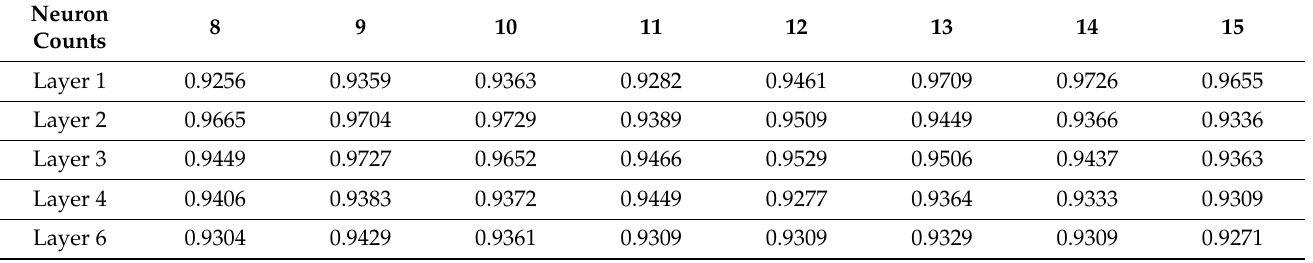
Table 5. Prediction accuracy of various counts of neurons in convolutional layers.